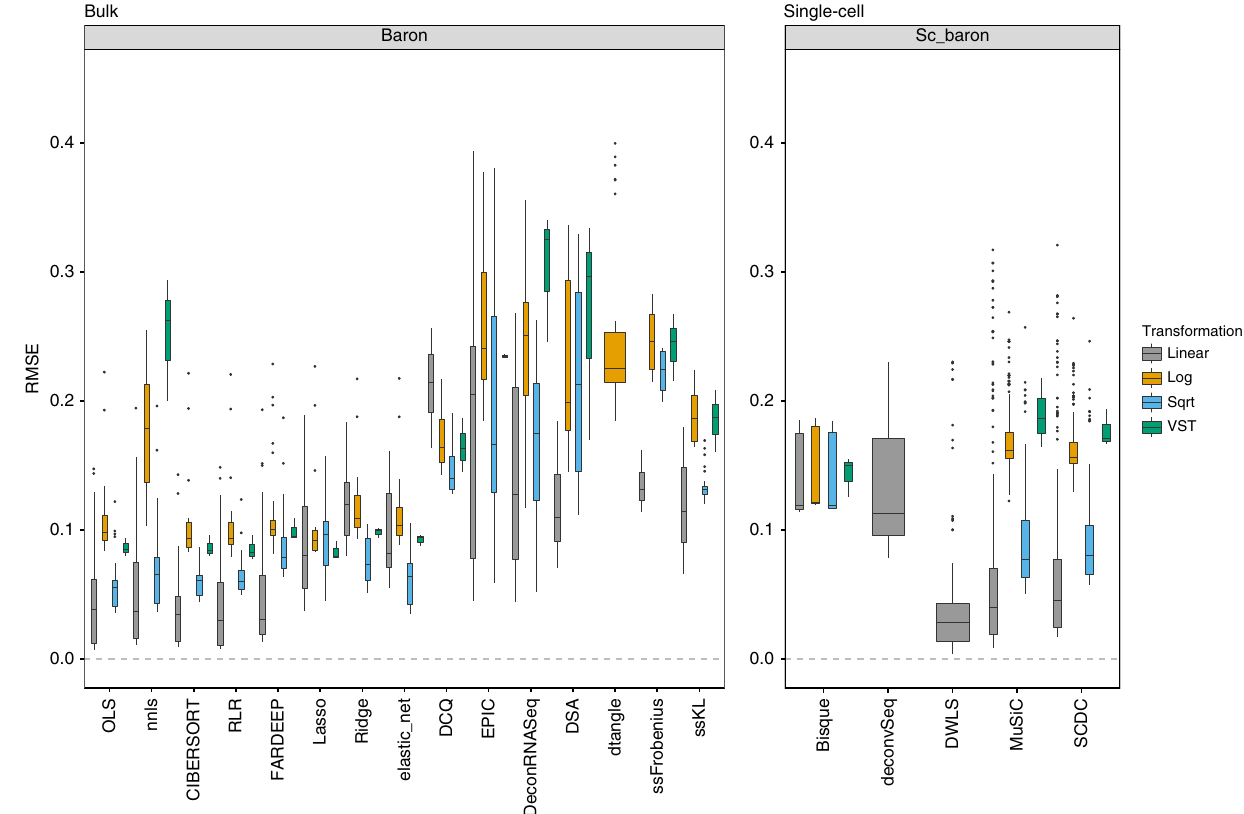
Fig. 2 Impact of the data transformation on the deconvolution results. RMSE values between the known proportions in 1000 pseudo-bulk tissue mixtures from the Baron dataset (pool size = 100 cells per mixture) and the predicted proportions from the different bulk deconvolution methods (left) and those using scRNA-seq data as reference (right). Each boxplot contains all normalization strategies that were tested in combination with a given